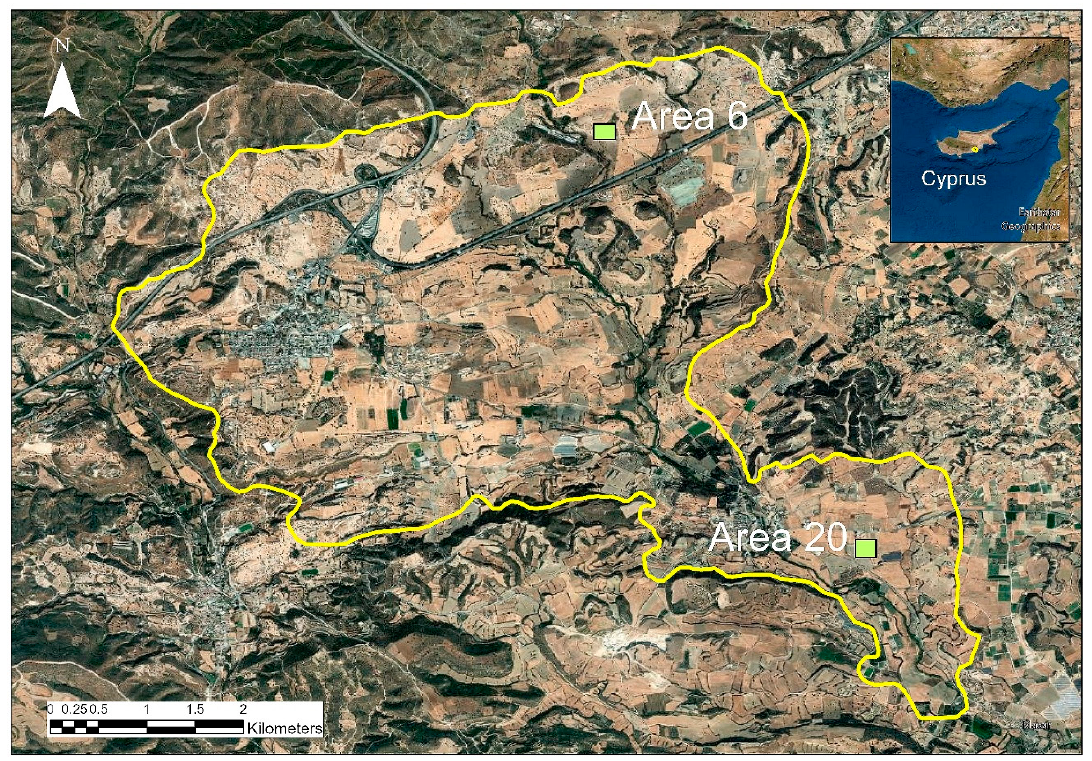
Figure 1. The survey area in the Xeros River valley (marked with the yellow line) under investigation by SeSaLaC and ArtLandS Lab (University of Cyprus), with the selected Areas 6 and 20 used as pilot case-studies for detecting surface pottery scatters using high-resolution UAV images.